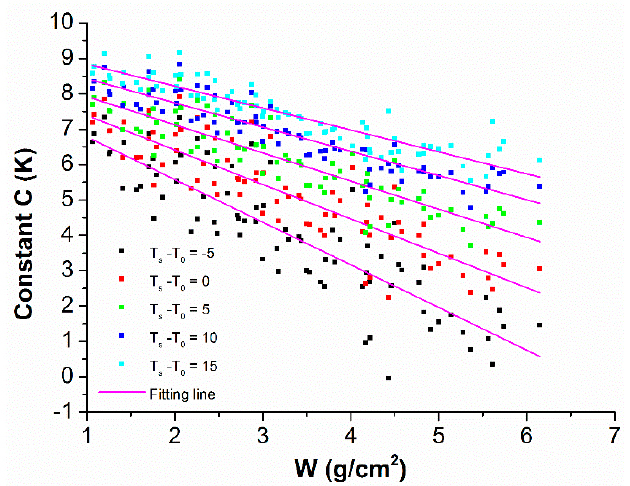
Figure 8. For water vapour content (W) greater than 1 g/cm 2 , constant C in Equation (1) as a function of W for a given surface-air temperature difference T s − T 0 .